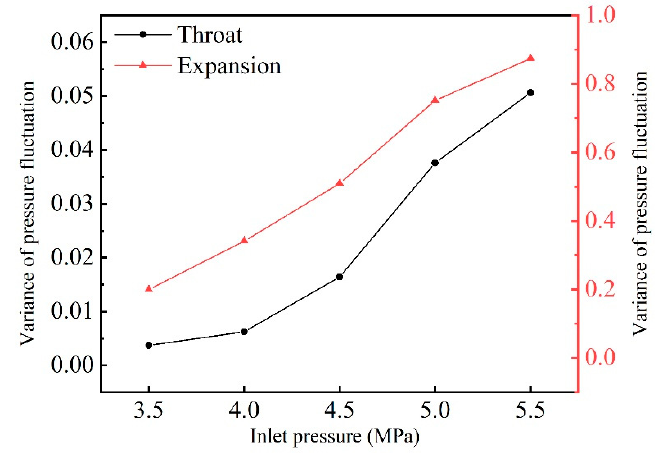
Figure 11. The variance of pressure fluctuation at throat and expansion section under increasing inlet pressures.